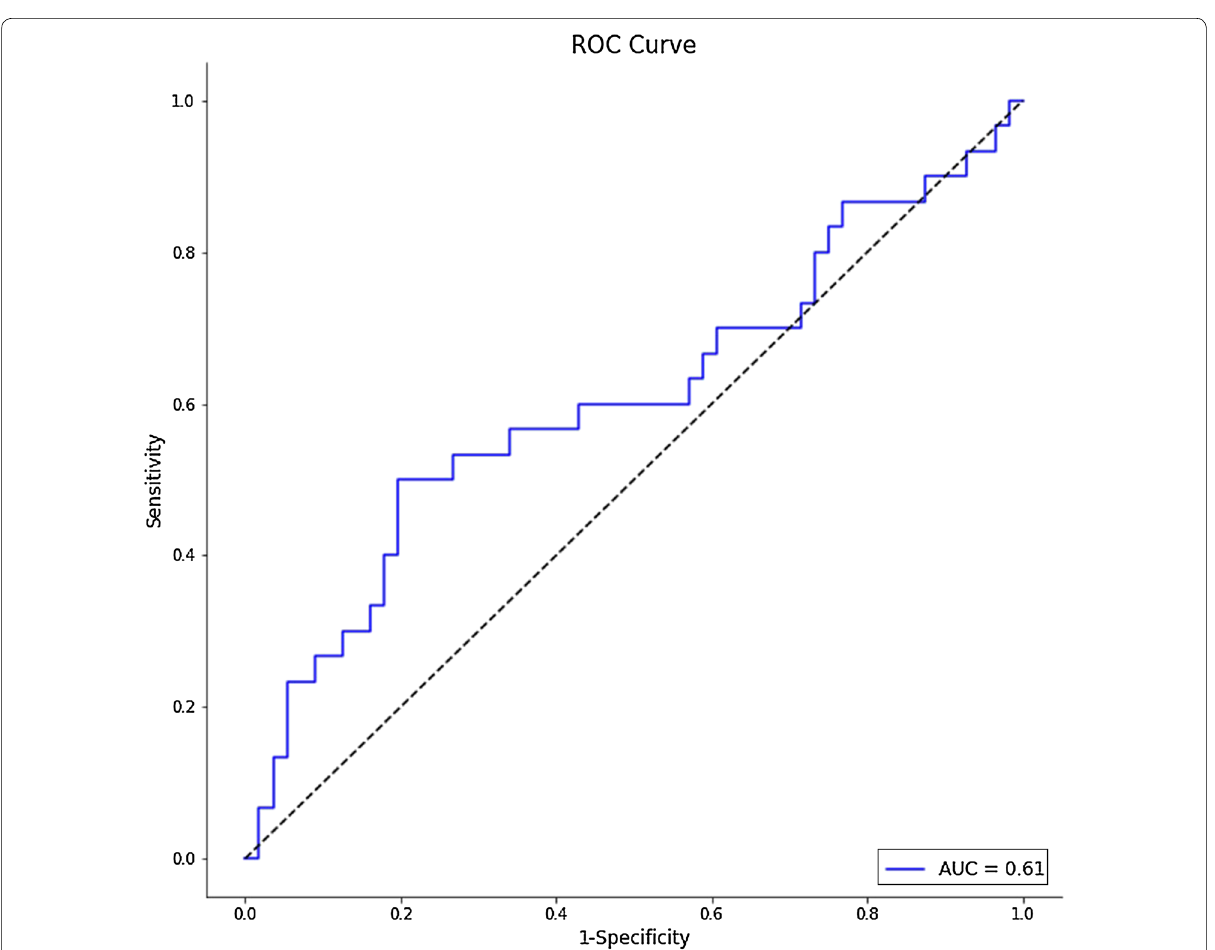
Fig. 2 The ROC curve for the convolutional neural networks in the testing dataset. AUC